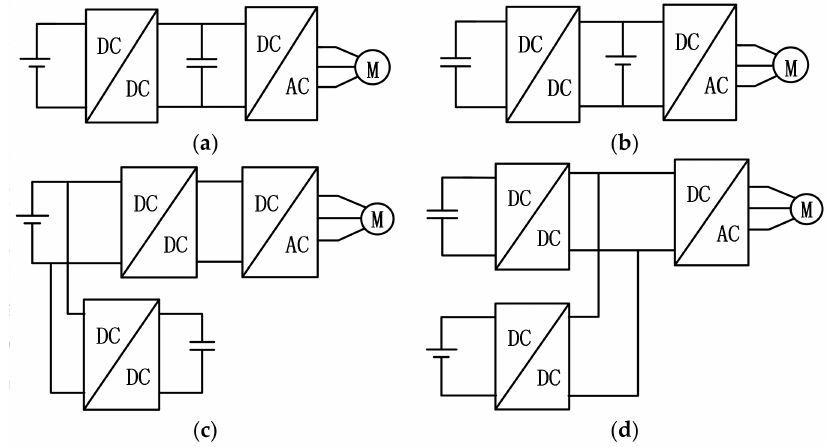
Figure 2. Common topologies for a hybrid power system. ( a ) Single DC/DC topology with controllable supercapacitor. ( b ) Single DC/DC topology with controllable battery. ( c ) Two-stage DC/DC topology. ( d ) Double DC/DC